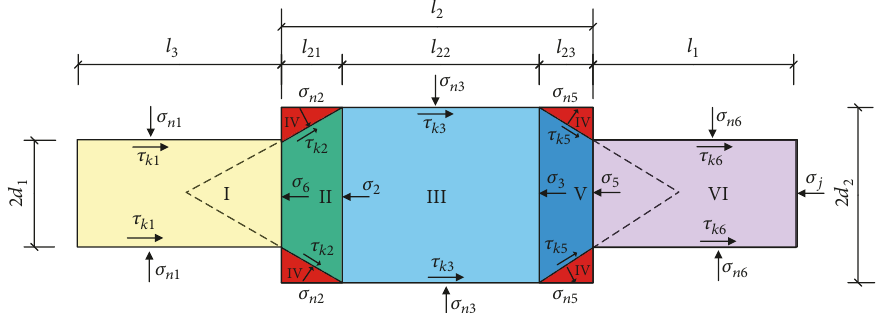
Figure 8: Stress diagram of lead in the back forward compressive